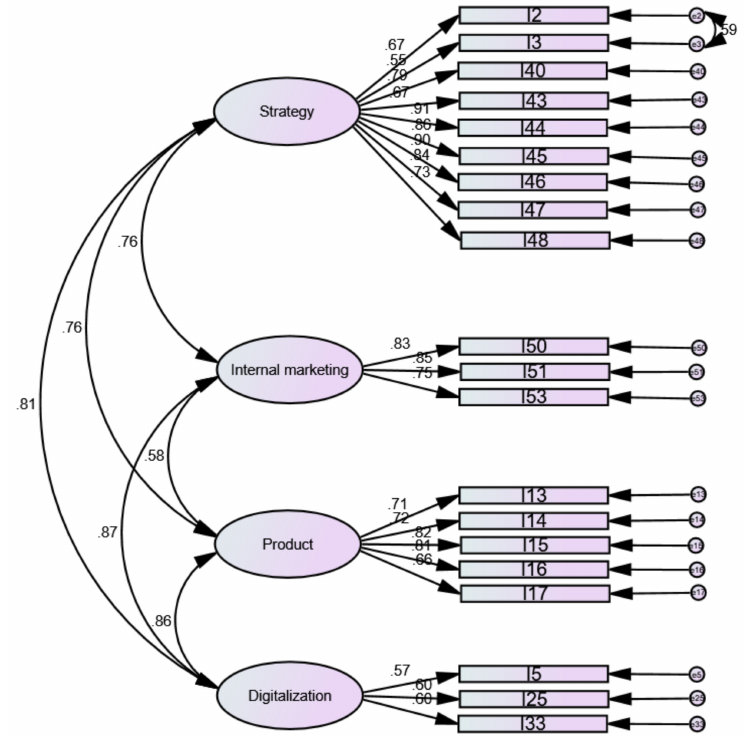
Figure 3. Model 3. The four-factor, 20 item confirmatory factor analysis (CFA) model of the Green Marketing Scale